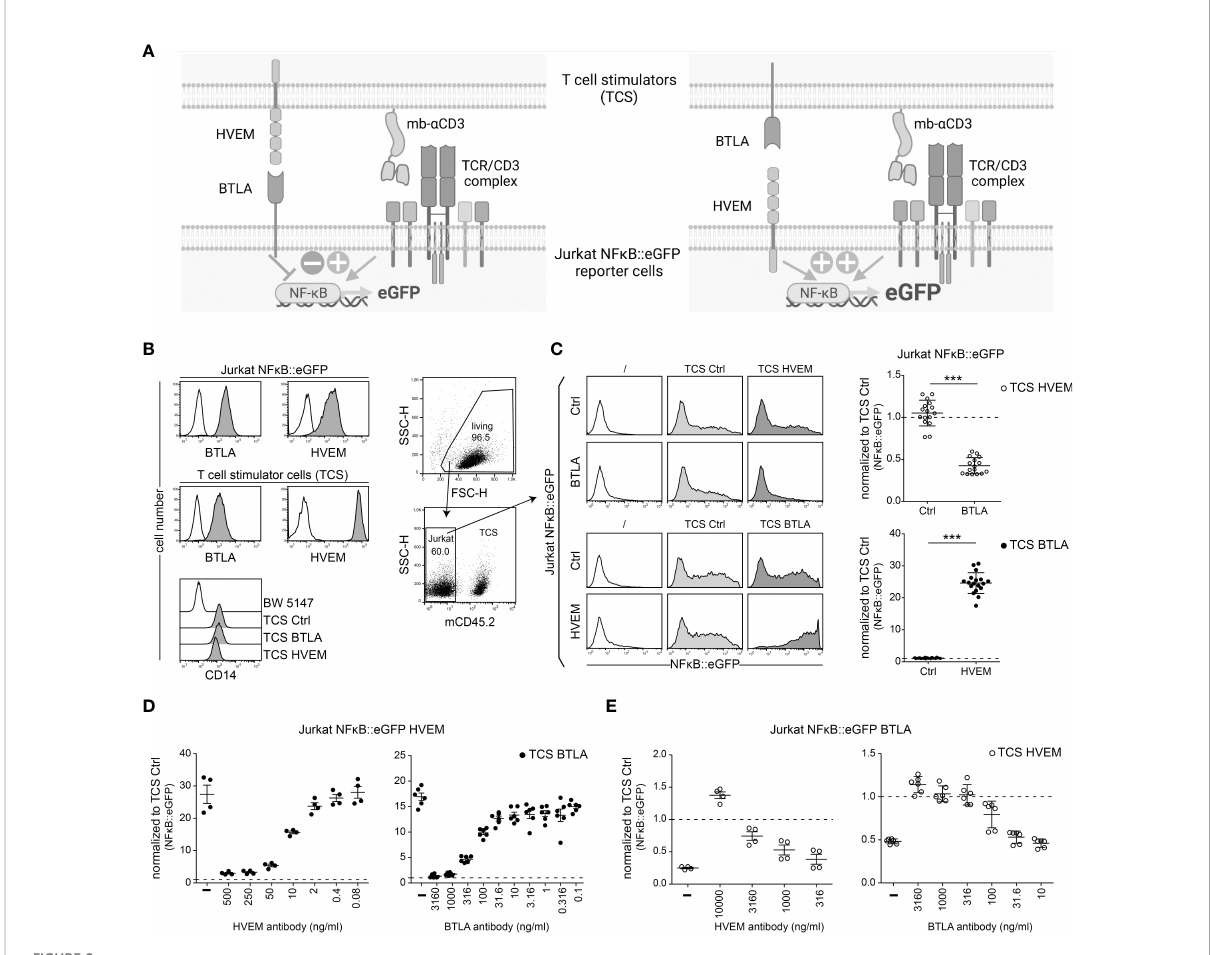
FIGURE 2 Evaluation of HVEM and BTLA signaling in a reporter cell-based system. (A) Schematics illustrating the evaluation of the HVEM/BTLA in Jurkat NF k B::eGFP reporter cells. Left: reporter cells expressing BTLA receive inhibitory signals via HVEM expressed on the TCS; Right: reporter cells expressing HVEM receive activating signals via BTLA expressed on TCS. (B) Expression levels of the indicated cell surface molecules on Jurkat NF k B::eGFP reporter cells and T cell stimulator cells (TCS) analysed via fl ow cytometry. TCS express a membrane-bound anti-human CD3 single chain fragment that is linked to a human CD14 stem (OKT3scFv-CD14). Parental BW5147 cells were used as a control. Open histograms represent control cells whereas grey histograms represent cells expressing the indicated molecules. (C) Left panels: Gating strategy used for reporter assays. TCS were excluded by using a mouse CD45.2 antibody and NF k B::eGFP expression was measured via fl ow cytometry. Middle panels: One representative experiment of control Jurkat NF k B::eGFP cells and Jurkat NF k B::eGFP expressing BTLA or HVEM stimulated with control TCS and TCS expressing HVEM or BTLA, respectively, is shown. Histograms of unstimulated reporter cells are also shown. Right panels: The indicated reporter cells were stimulated with TCS HVEM or TCS BTLA and eGFP expression is shown normalized to stimulation with control TCS (dotted line). Results of BTLA and HVEM reporter cells are from 8, respectively 9, independent experiments performed in duplicates. For statistical evaluation, unpaired t-test was performed (***p ≤ 0.001). (D) Jurkat NF k B::eGFP cells expressing HVEM were stimulated with